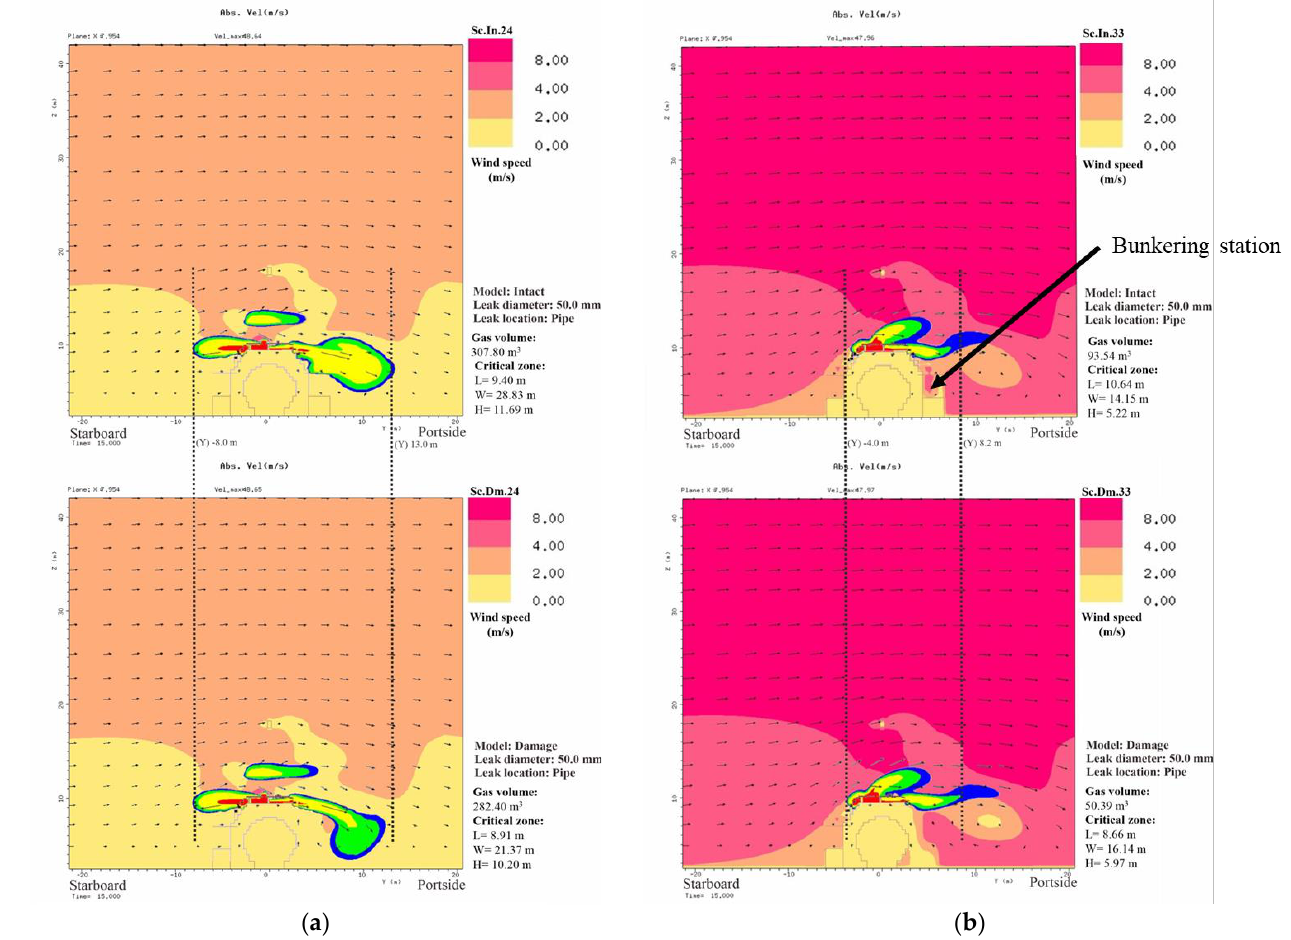
Figure 19. The combined wind velocity (wind direction is marked as arrows) and gas concentration plots of 2 m/s ( a ) and 8 m/s wind speed ( b ).